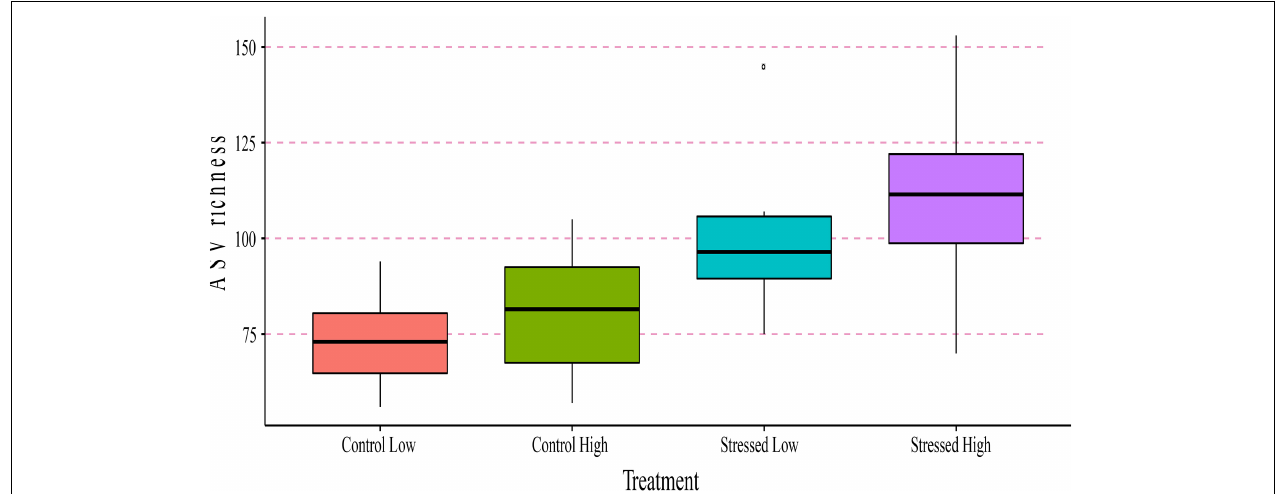
FIGURE 7 | Boxplots of amplicon sequence variant (ASV) richness evaluated in Crassostrea gigas larvae after 96 h (day 15 PF) per treatment condition (Control Low, Control High, Stress Low, and Stress High). Median values and the lower (25%) and upper (75%) quartiles are presented. Whiskers indicate the minimum and maximum values, while outliers are displayed as